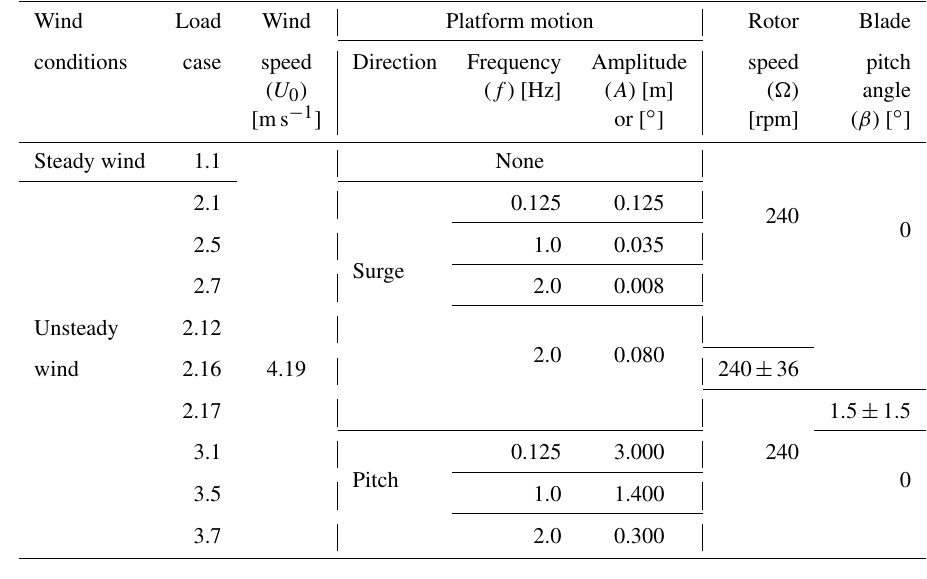
Table 4. Offshore Code Comparison Collaboration, Continued, with Correlation and unCertainty (OC6) Phase III load case simulations